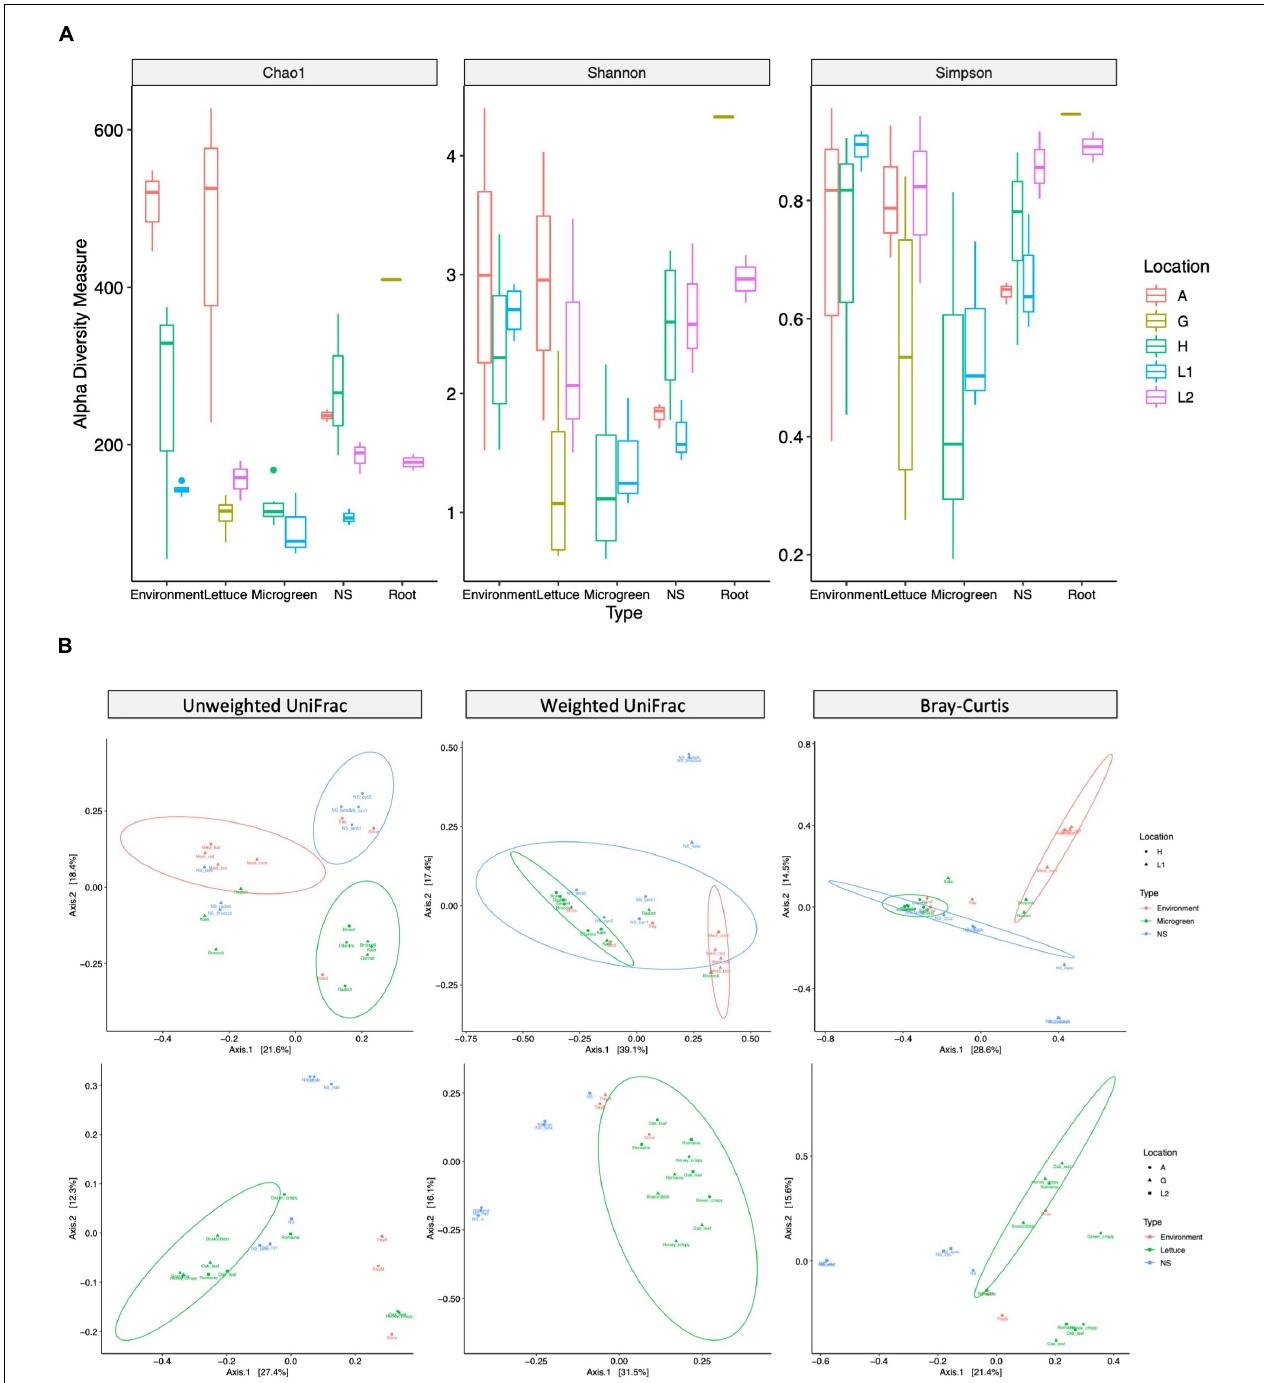
FIGURE 3 | Alpha- and beta-diversity measurements of bacteria communities. (A) Alpha-diversity: the community richness and evenness of different sample types. Alpha-diversity index: chao1 measures community richness; Shannon and Simpson measure community richness and evenness. The box represents the first and third quartiles, the center line represents the median, and whiskers as min-to-max values. (B) Beta-diversity: microbiome compositional difference between sample types. Samples are grouped by microgreen (top row, H and L1) or lettuce (bottom, A, G, and L2) systems. Unweighted UniFrac (left, presence of taxa), weighted UniFrac (middle, presence and relative abundance of taxa), and Bray–Curtis (right, presence and relative abundance of taxa) distance are visualized by PCoA plots. The ellipses indicate 95% confidence regions for clusters by the normal distribution.